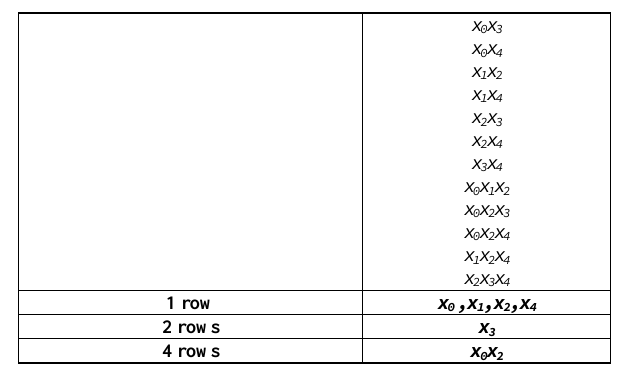
Table 5 : Output of Zero row (above).